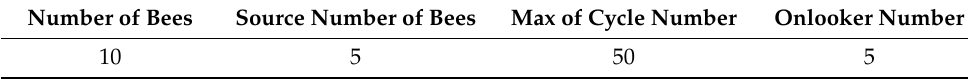
Figure 8. Cost graph for 100 replications of the PCA-ABC-ANN model as the best model.